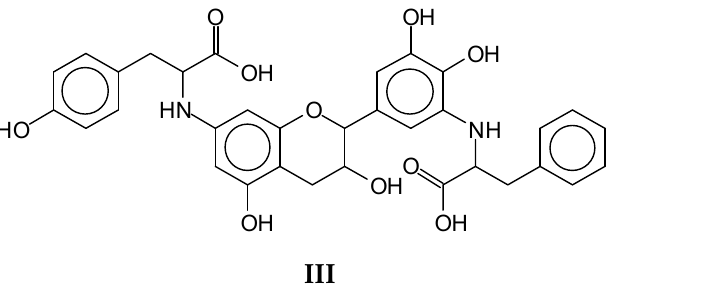
Figure 6 . Example of a species ( III ) not contributing to the linking of the protein with the tannin, as the amino group involved in the reaction it cannot react once it is is an amido group in the peptide chain.